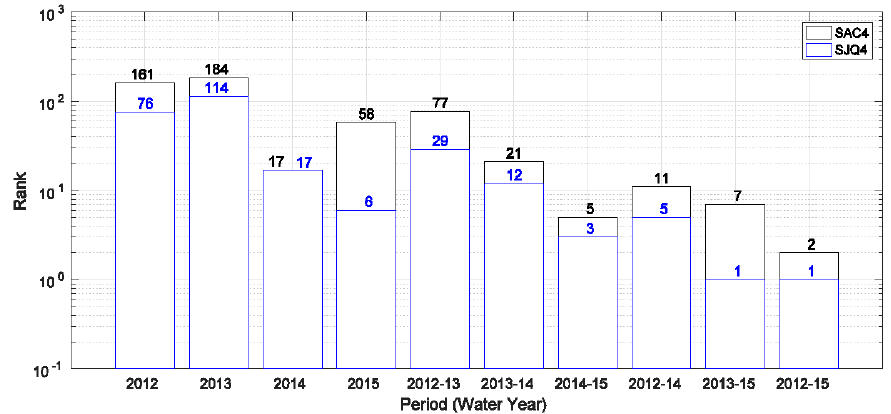
Figure 7. Rank of Sacramento Four River flow and San Joaquin Four River flow in a paleoclimatic context (from 900–2015) in different sub-periods within 2012–2015.